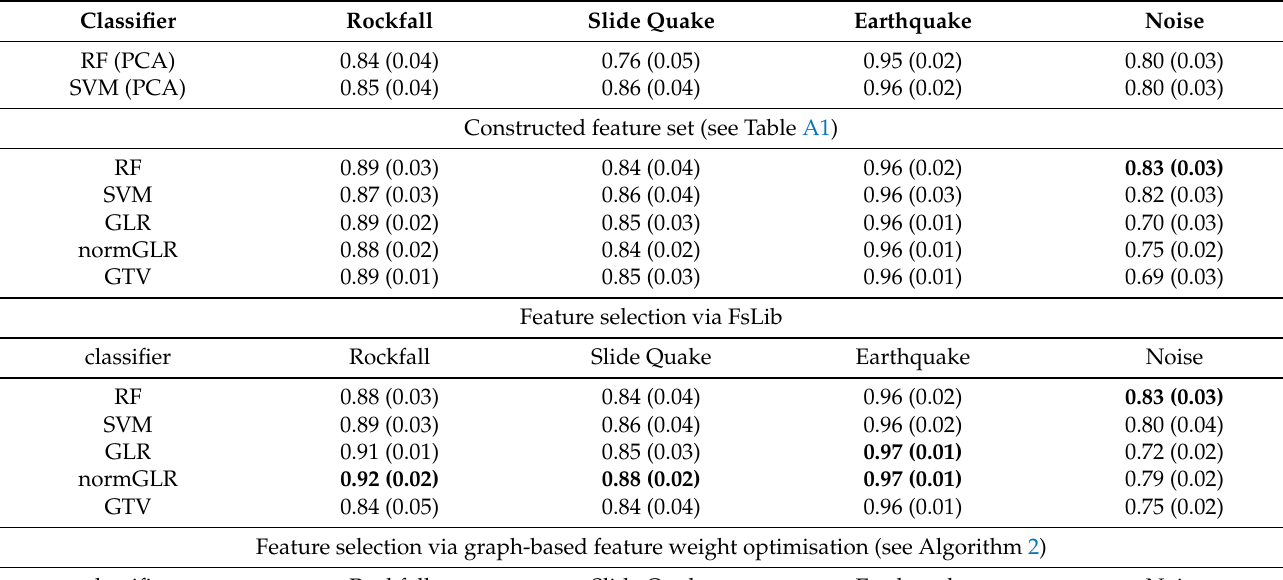
Table 3. Sensitivity (mean and standard deviation).